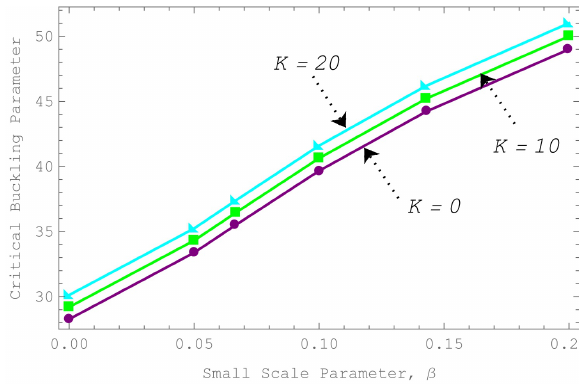
Figure 7: Size effects on the critical buckling loads for different elastic matrix parameter( K = 0, 10, 20 )